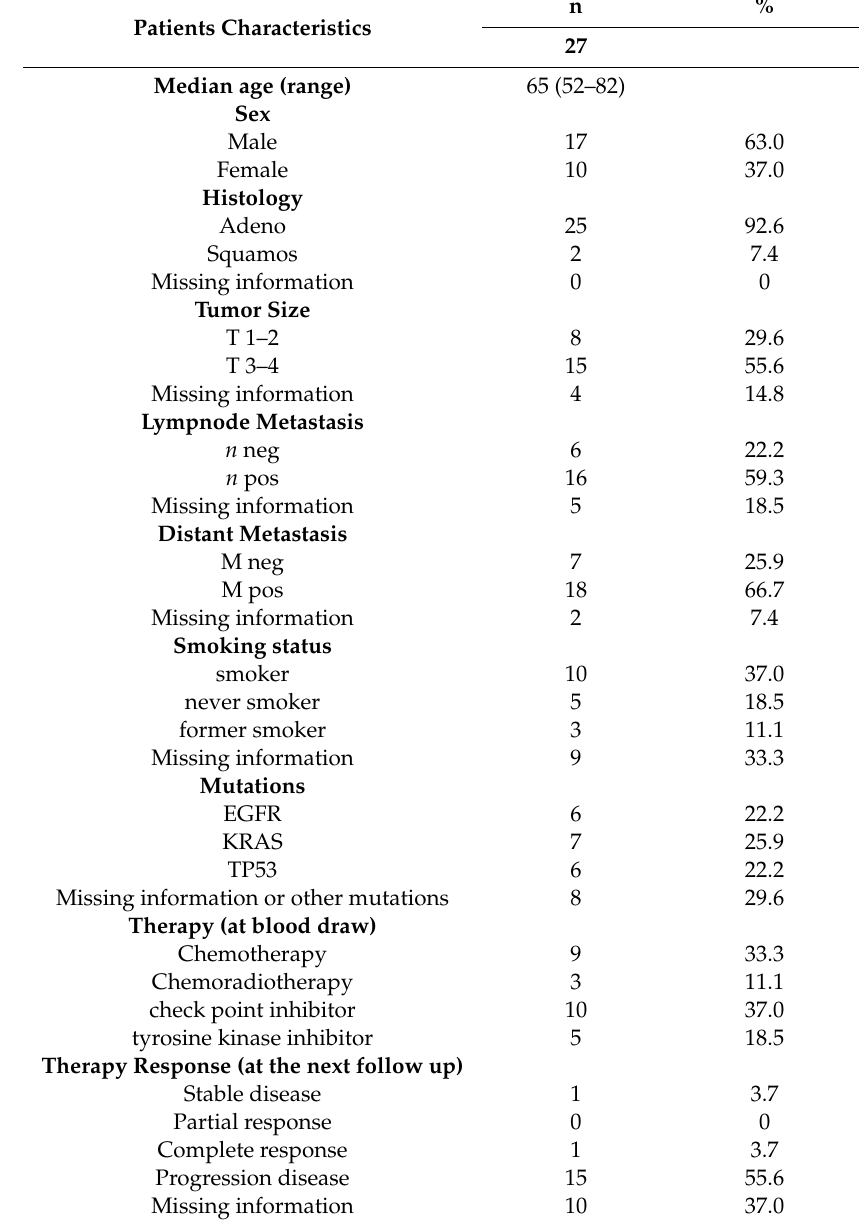
Table 2. Patients’